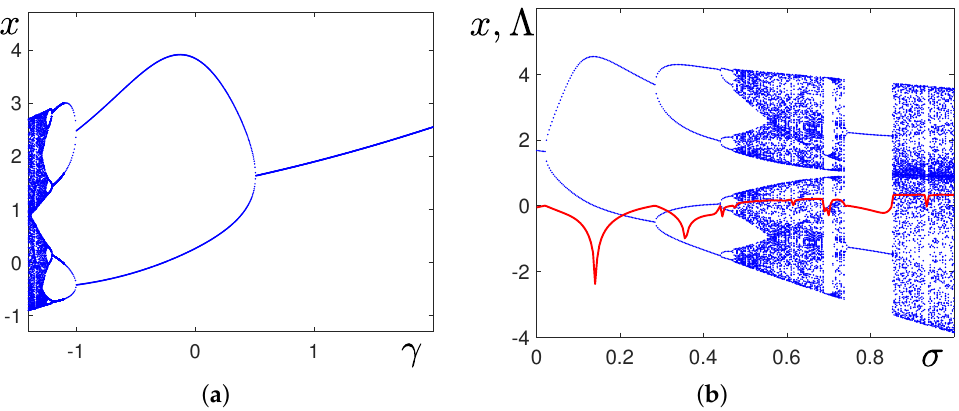
Figure 1. Bifurcation diagrams of ( a ) isolated Rulkov map versus control parameter γ and ( b ) cou- pled system (1) with γ = 0.6 versus coupling parameter σ , using identical initial conditions. The red line shows the largest Lyapunov